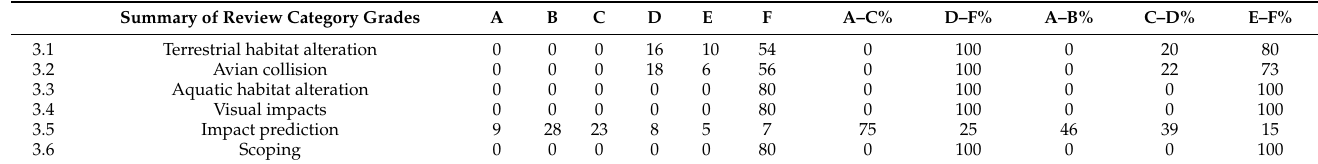
Table 7. Allocation of quality to environmental assessment tasks performed under Review Area